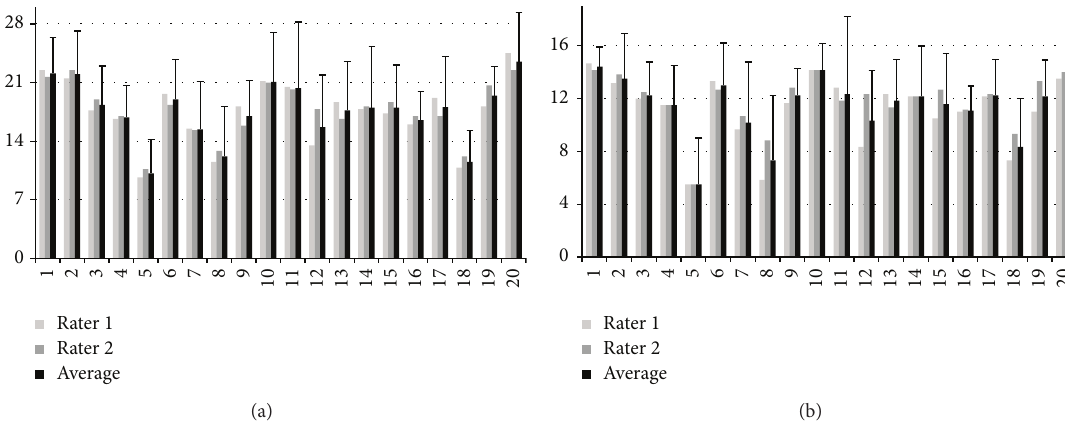
Figure 5: Overall subject performance assessment scores from the Global Rating Scale (a) and Crisis Management Checklist (b). Individual rater and average ratings are shown. The bars depict standard